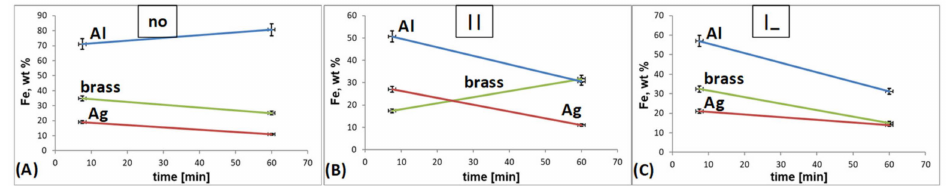
Figure 4. Time influence on the Fe content in the FeNi alloy deposited on different substrates, current density—50.0 mA/cm 2 : ( A ) without EMF, ( B ) parallel EMF, ( C ) perpendicular